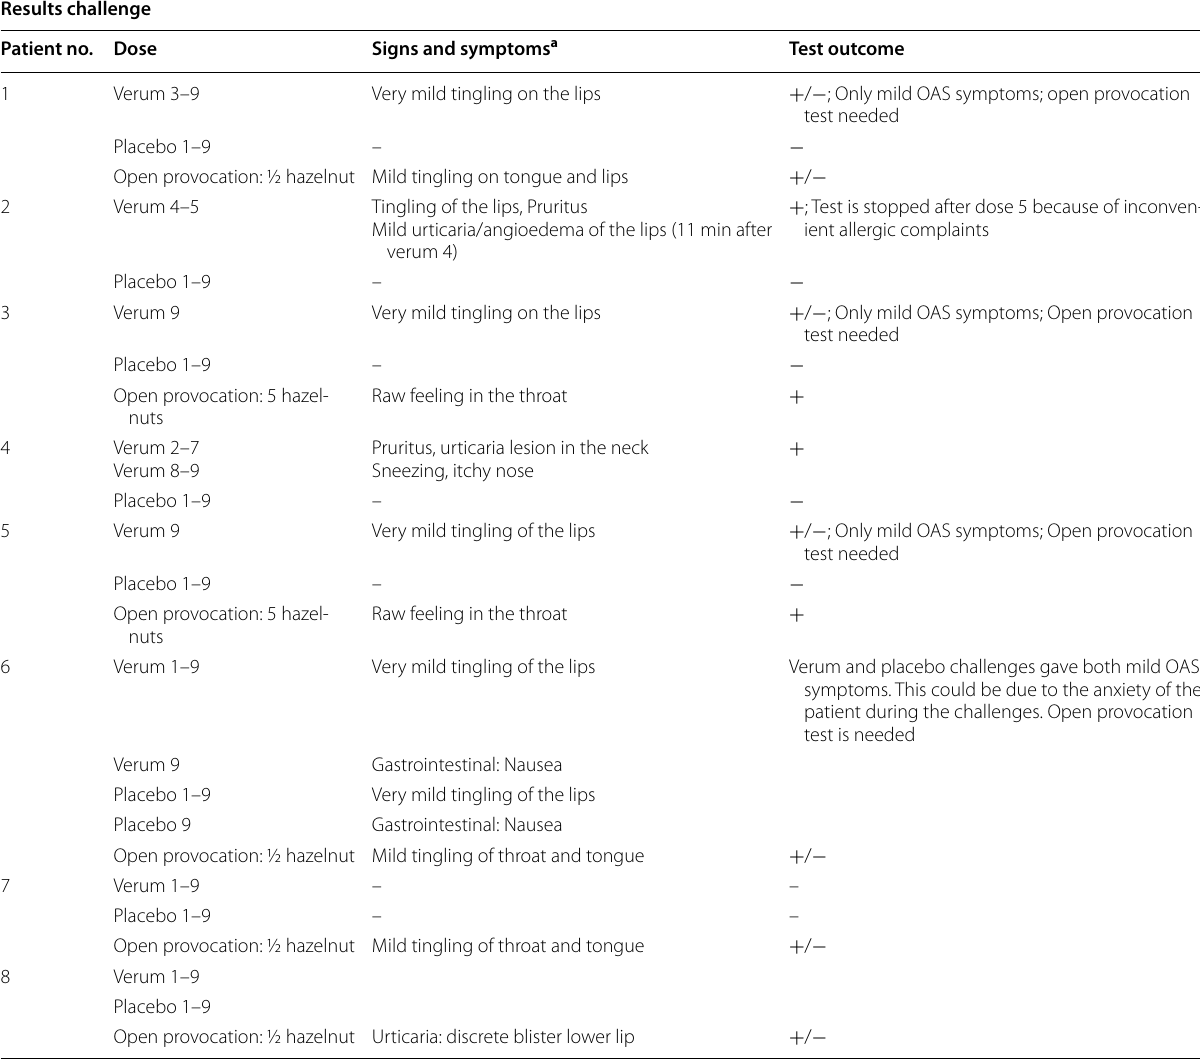
Table 3 DBPCFC results of the eight